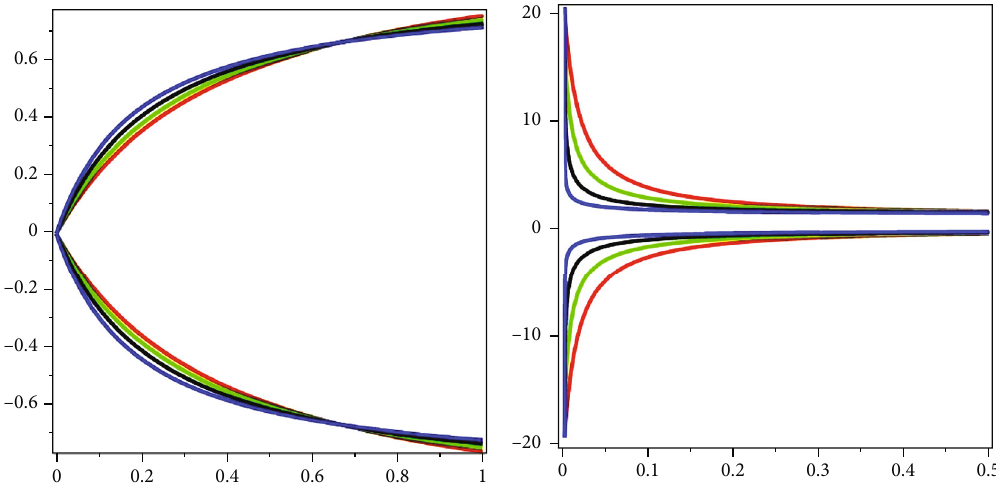
Figure 4: The fi rst graph shows the fuzzy 2D upper and lower fi gure of the various fractional orders of γ .